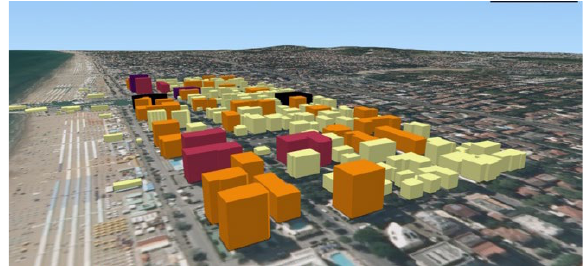
Figure 11. 3D City Model graphical representation with LoD1 buildings classified according to their new volume